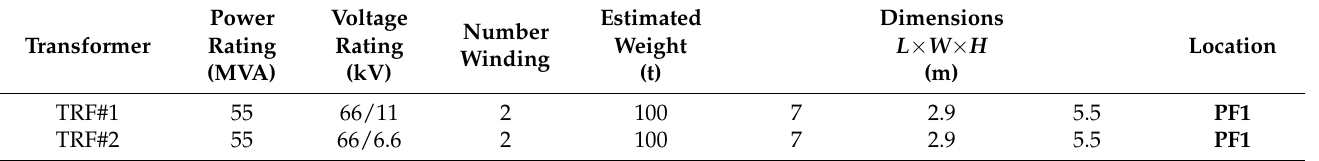
Table A2. Transformers design for Architecture 1.